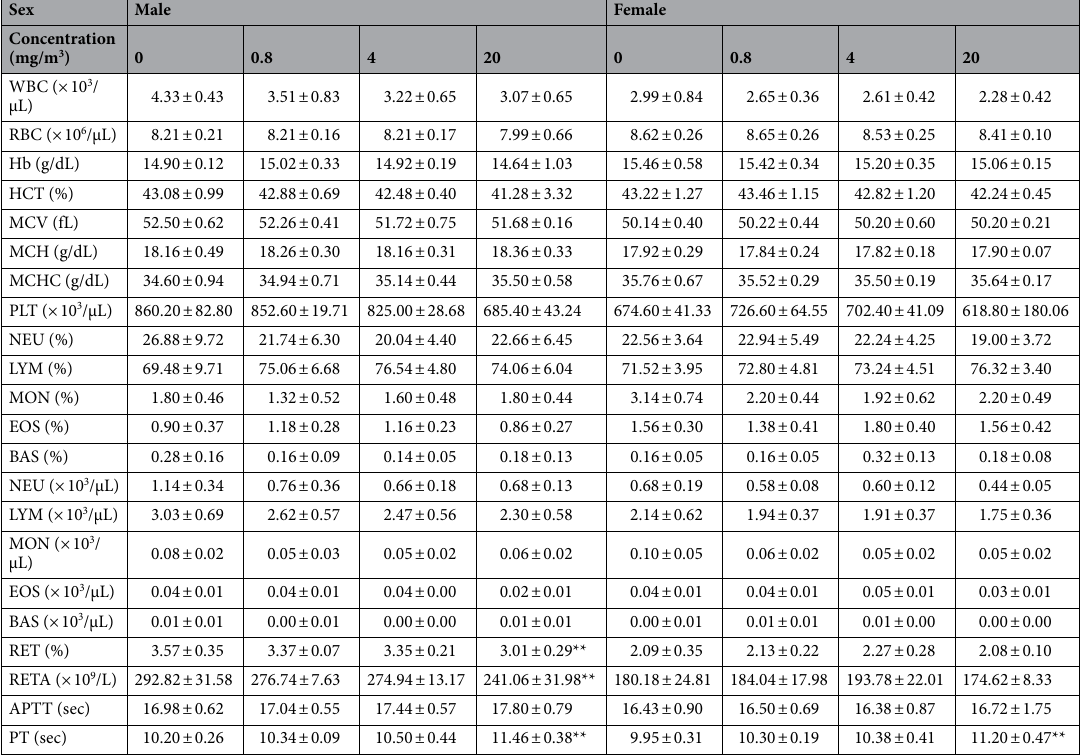
Table 1. Hematological parameters of main group rats exposed to NaDCC. The values are expressed as mean ± SD (n = 5 males and 5 females per group), **Dunnett LSD Test Significant at the 0.01 level.